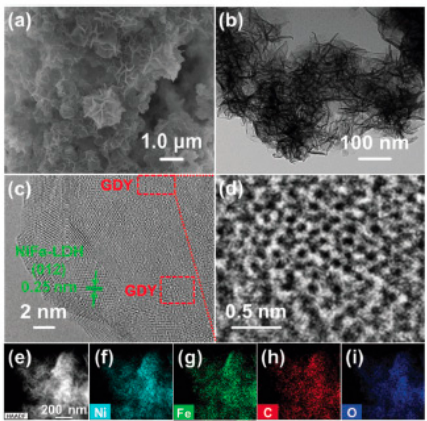
Figure 26. Structural features of graphdiyne (GDY). Reproduced from [98], with permission from the Royal Society of Chemistry, copyright 2018.